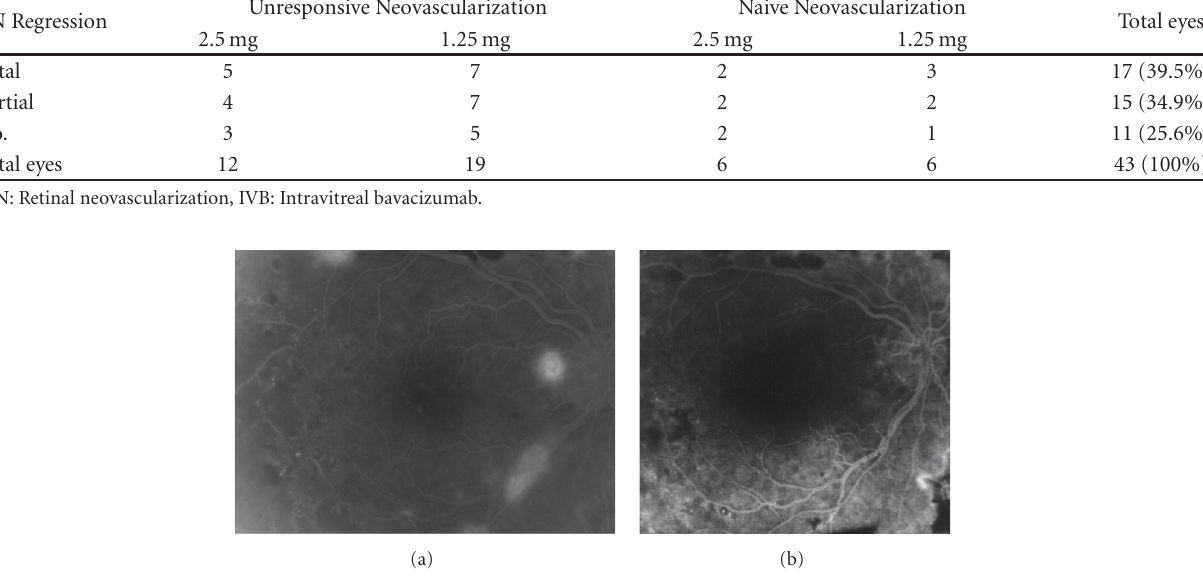
Figure 4: A 53-year-old man had a 2-month history of visual loss to 20/60 in his right eye. We had performed panretinal photocoagulation (PRP) in his right eye 2 years previously. Fundus examination revealed a mild vitreous hemorrhage. (a) Fluorescein leakage from neovascu- larizationof the disc (NVD) at baseline between retinal vessels crossing the optic disc wasdemonstrated. In addition, fluorescein angiography (FA) showed magnification of retinal neovascularization elsewhere (NVE) in the superonasal retina. (b) At week 1 after intravitreal bevacizumab, total resolution of leakage from NVD and NVE are shown. His visual acuity returned to 20/32 one month later. He needed a reinjection at months 6, 14, and 24 of followup. A PRP was performed at 24